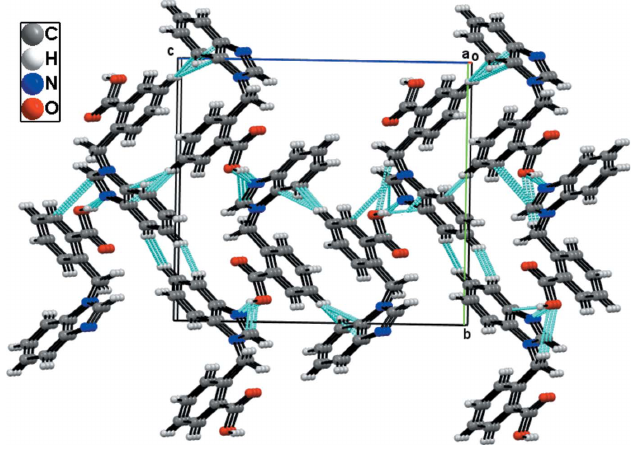
Figure 2 View of the crystal packing along the a axis, showing O—H (cid:3)(cid:3)(cid:3) N and C— H (cid:3)(cid:3)(cid:3) O hydrogen-bonding interactions forming a one-dimensional chain.